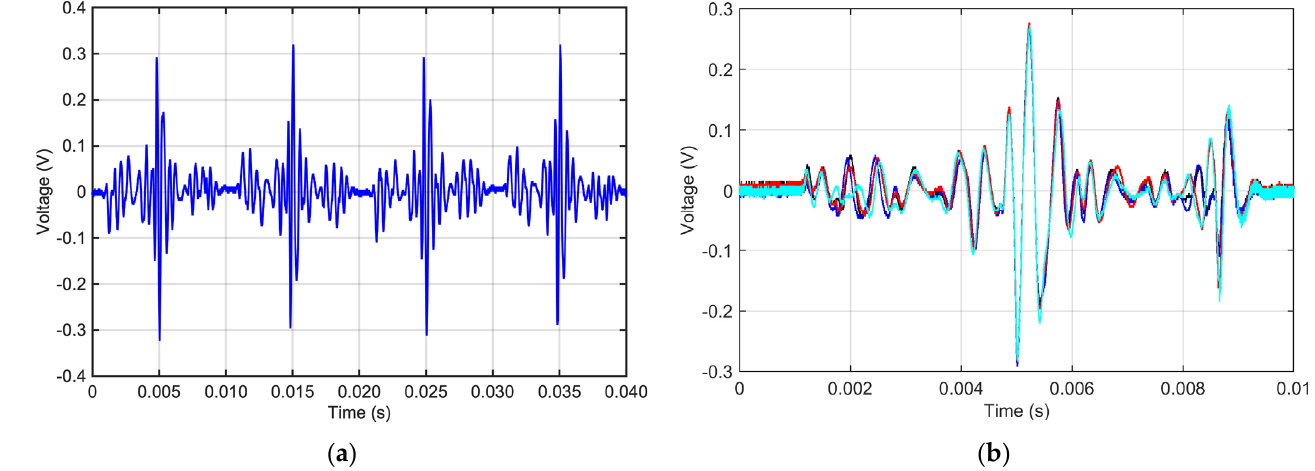
Figure 3. Typical time-domain waveform of an SMPS at the high-pass filtered LISN output measured as the DSO input signal y 1 : ( a ) pattern repetition every 10 ms with alternated polarity for KT-P25; ( b ) 4 records, 2 for the positive half-period and 2 for the negative half-period, for LB-P90, showing correspondence for the main pulses but were different in terms of oscillation frequency and damping.